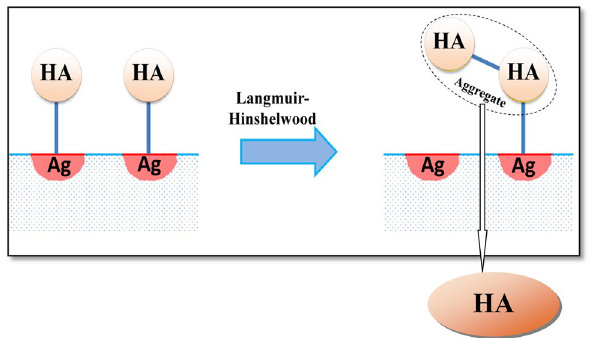
Fig. 6 UV spectra of test solution of HA (red) and that after its removal by Ag